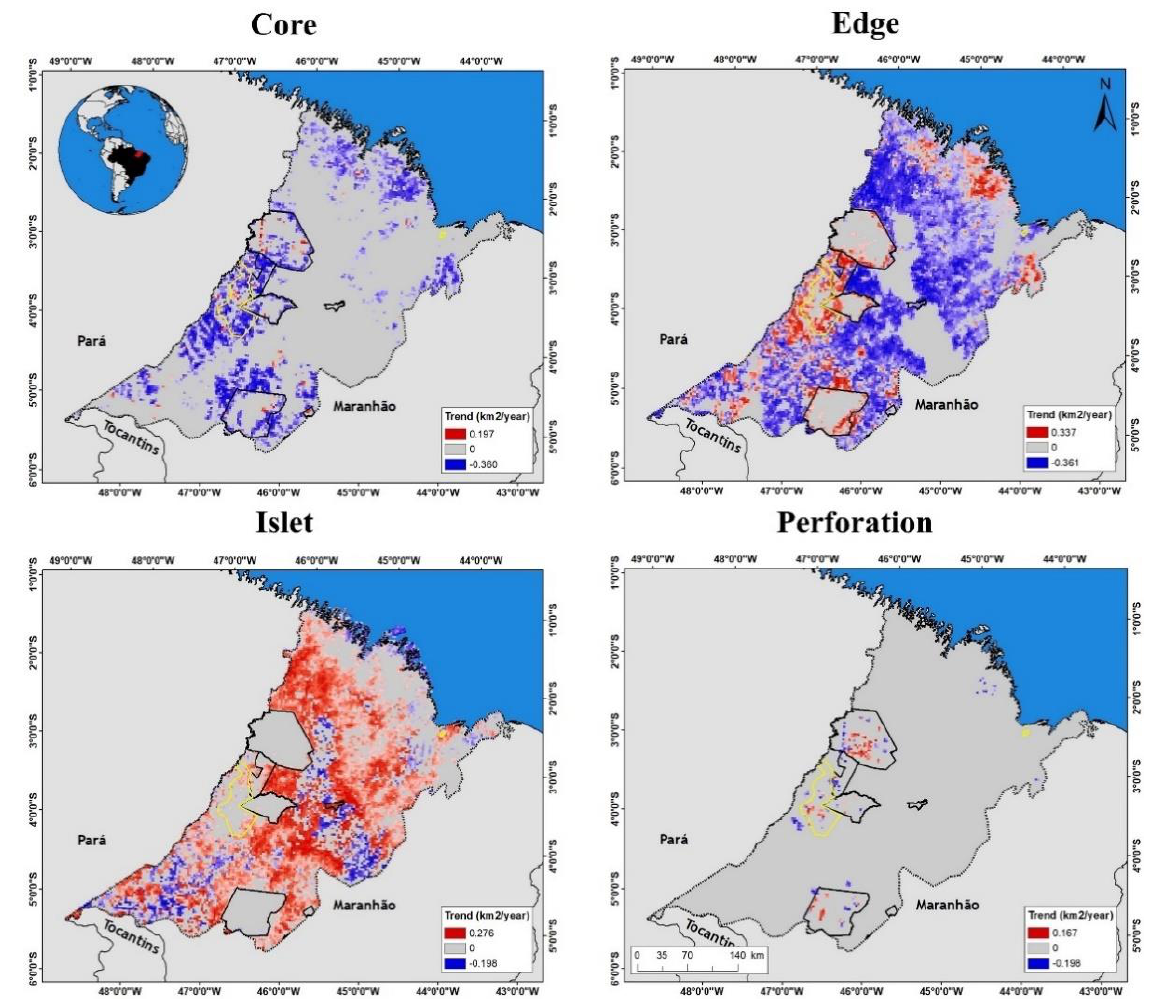
Figure 3. Spatial trends (Sen’s Slope estimator) for each fragmentation class between 1985 and 2017 in the Amazon region of Maranh ã o, Brazil. Areas were calculated in pixels with 10 km spatial resolution. Negative values (in blue) represent the decrease trend, while positive values (in red) represent the increase